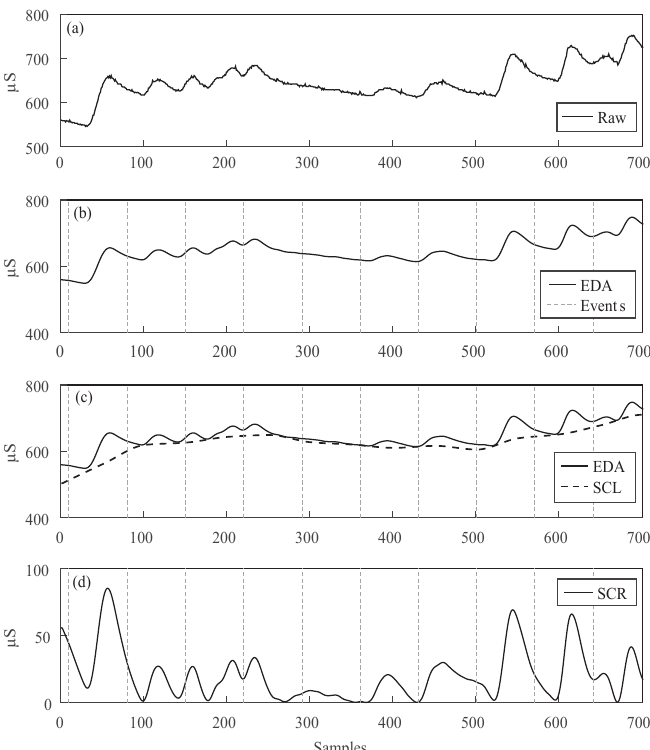
Figure 3. Different stages in EDA signal processing. ( a ) Raw EDA signal before filtering. ( b ) Raw EDA signal after low-pass filtering and stimuli onset. ( c ) Estimation of EDA baseline using a cubic spline approximation. ( d ) Skin conductivity response (SCR) obtained after the convolution process.